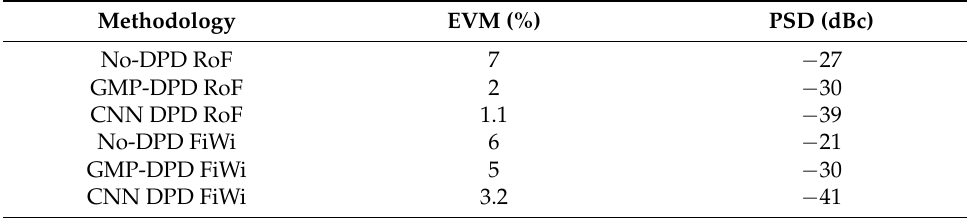
Table 4. Synopsis of the results for E.V.M and PSD as performance metric.